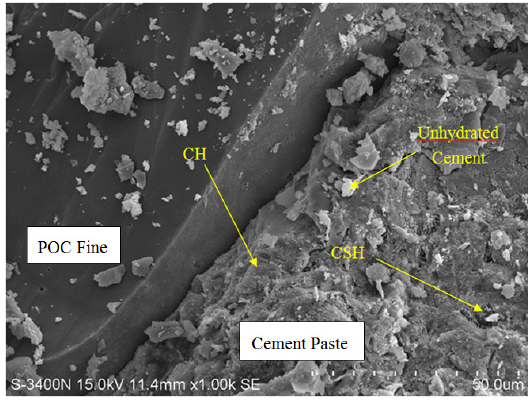
Figure 16. Aggregate cement paste interface.